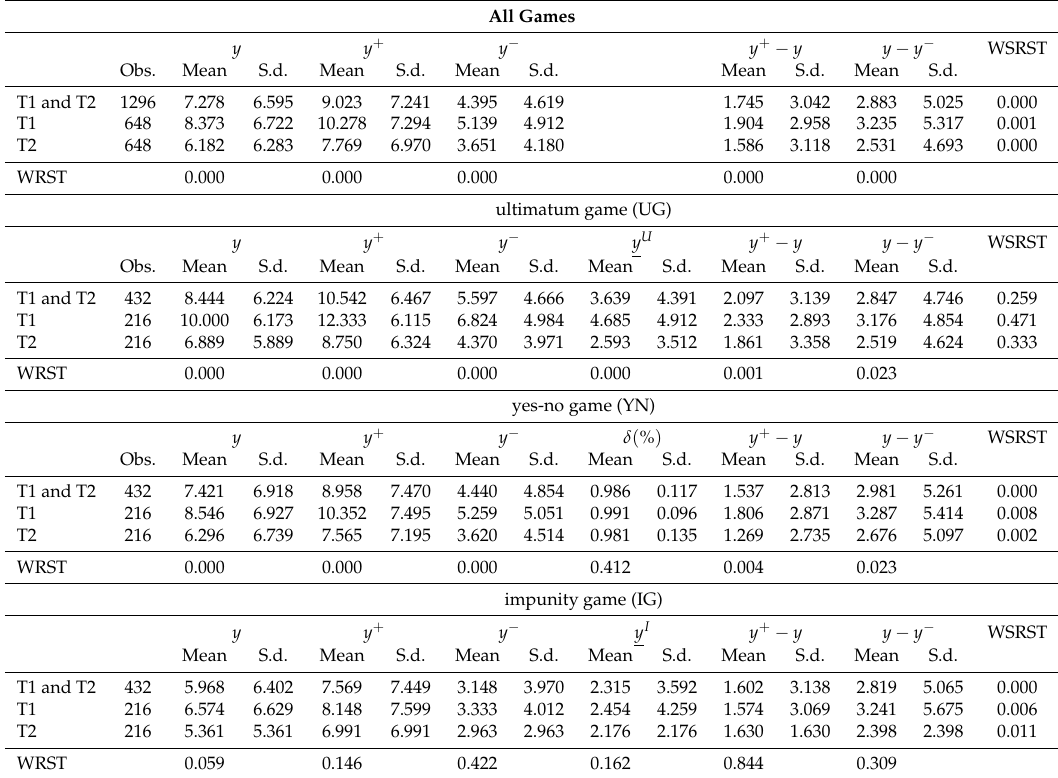
Table 2. Average offers y , y + , y − , acceptance behavior y U , δ , y I and differences y + − y , y − y −